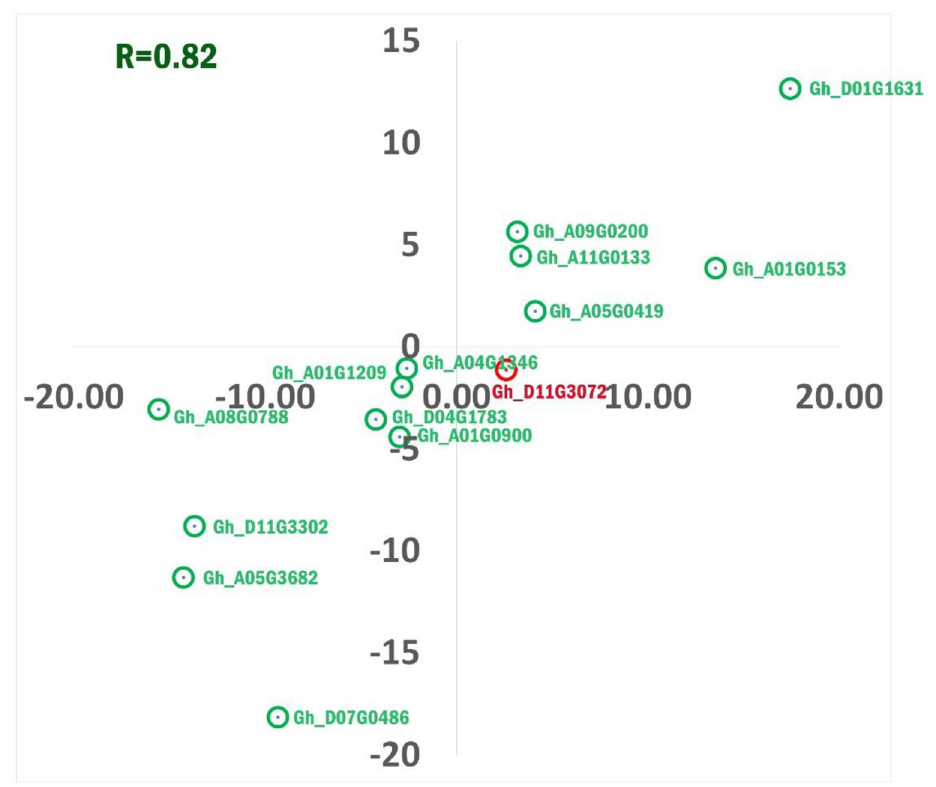
Fig 6. qRT-PCR analysis of gene expression compared with the RNA-seq data. Expression of 14 transcript as analyzed by quantitative PCR in CGMS and fertile lines of Gossypium hirsutum L. The dots with green colour (thirteen in numbers) indicates concordance whereas, red (one in number) indicates non-concordance of expression profiling in qRT-PCR and RNA-seq.